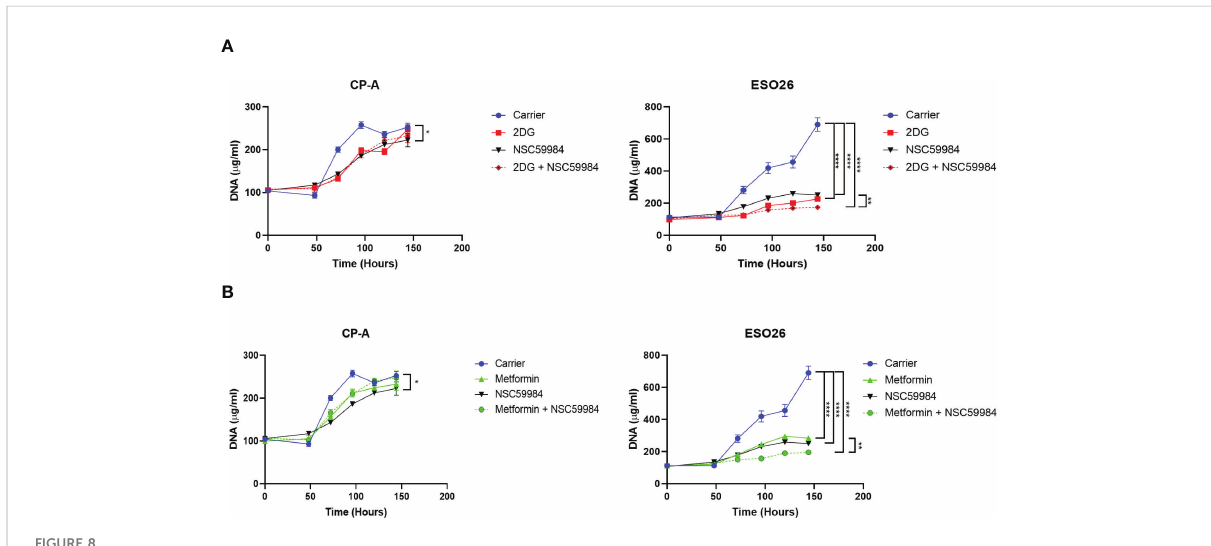
FIGURE 8 Combination of NSC59984 with metabolic inhibitors shows improved effects. (A) Analysis of cellular proliferation over a period of 5 days following 48 hr treatment with either Metformin (5 mM), NSC59984 (12 m M) or a combination in EAC cells (B) Analysis of cellular proliferation over a period of 5 days following 48 hr treatment with either 2DG (5mM), NSC59984 (12 m M) or a combination in EAC cells. In all panels, cellular proliferation was measured by CyQUANT analysis of cellular DNA. A 2-way ANOVA test with Tukey correction was carried out for statistical analysis. * = 0.05, ** = 0.005, *** = 0.0005, **** =